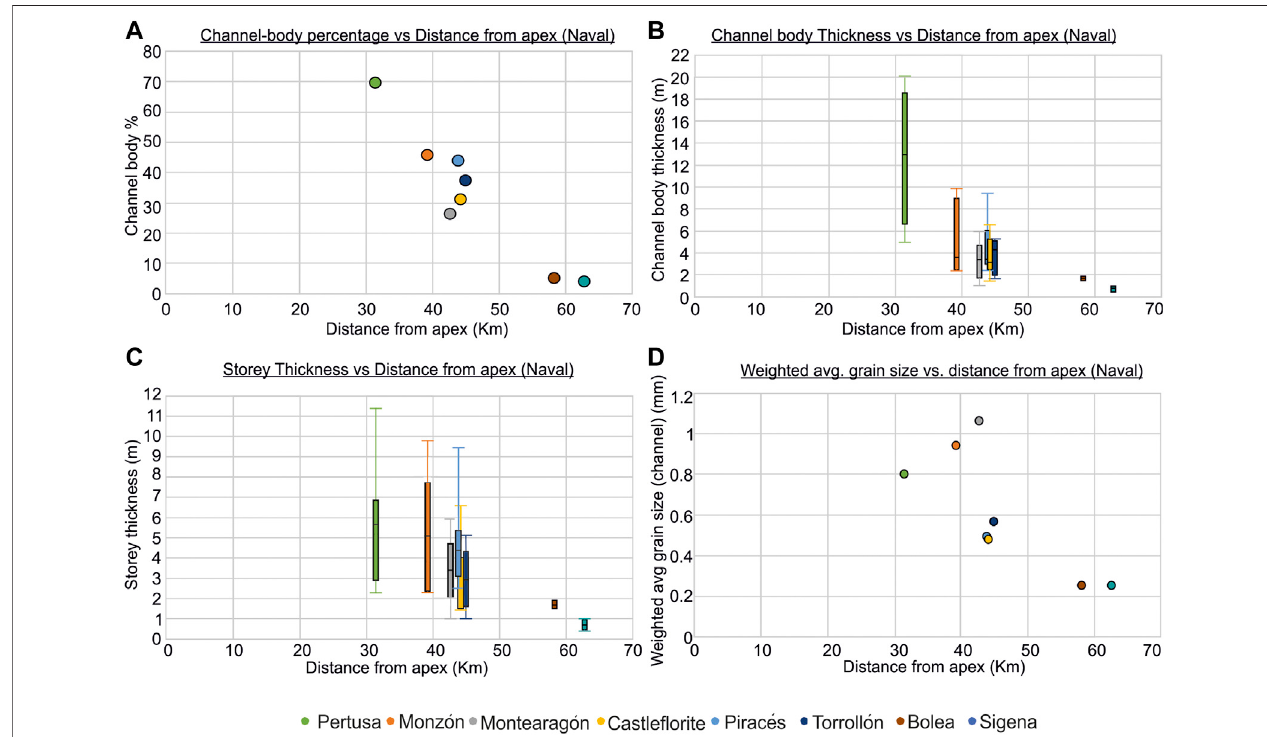
FIGURE6| Spatial trends onthe Huesca DFS. The Naval apex location hasbeen used todepict distancedownstream. (A) Channel body percentage vs. distance downstream. (B) Channel body thickness vs. distance downstream. The data are represented as box and whisker plots. (C) Storey thickness v distance downstream. The data are represented as box and whisker plots. (D) Weighted average grain size vs. distance downstream.